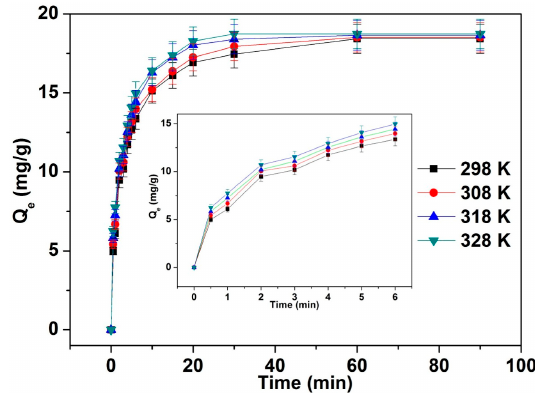
Figure 6. Iron adsorption by resin Rexp-501 at iron concentrations of 5000 mg·L − 1 .